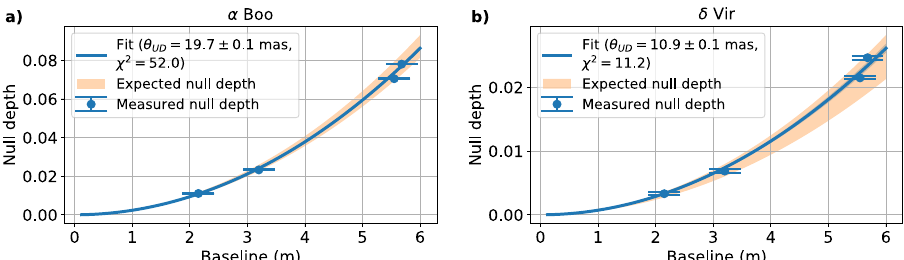
Fig. 8 Variations of the source null depth of α Boo and δ Vir and their respective fi tted curves with respect to the baseline. a Variation of the source null depth of α Boo (blue dots) as a function of baseline together with the best- fi t model (blue solid curve). The orange area highlights the expected range of null depth at 1550 nm for an expected UD diameter between 19.1 and 20.4 mas (obtained from the literature). Error bars represent the standard error of the measurements. b Source null depth of δ Vir (blue dots) with baseline together with the best- fi t model (blue solid curve). The orange gives the expected range of null depth for a UD diameter between 9.86 and 11.3 mas (from the literature). The error bars represent the standard deviation of the fi tted value of the source null depth given by the covariance matrix of the fi t of the histogram, rescaled by the reduced χ 2 of that fi Active optical elements within the instrument allow delays to be fi nely adjusted, switching different pairs into null operation, or even swapping null and anti-null con fi guration. The instrument also boasts multi-channel spectral information by way of a